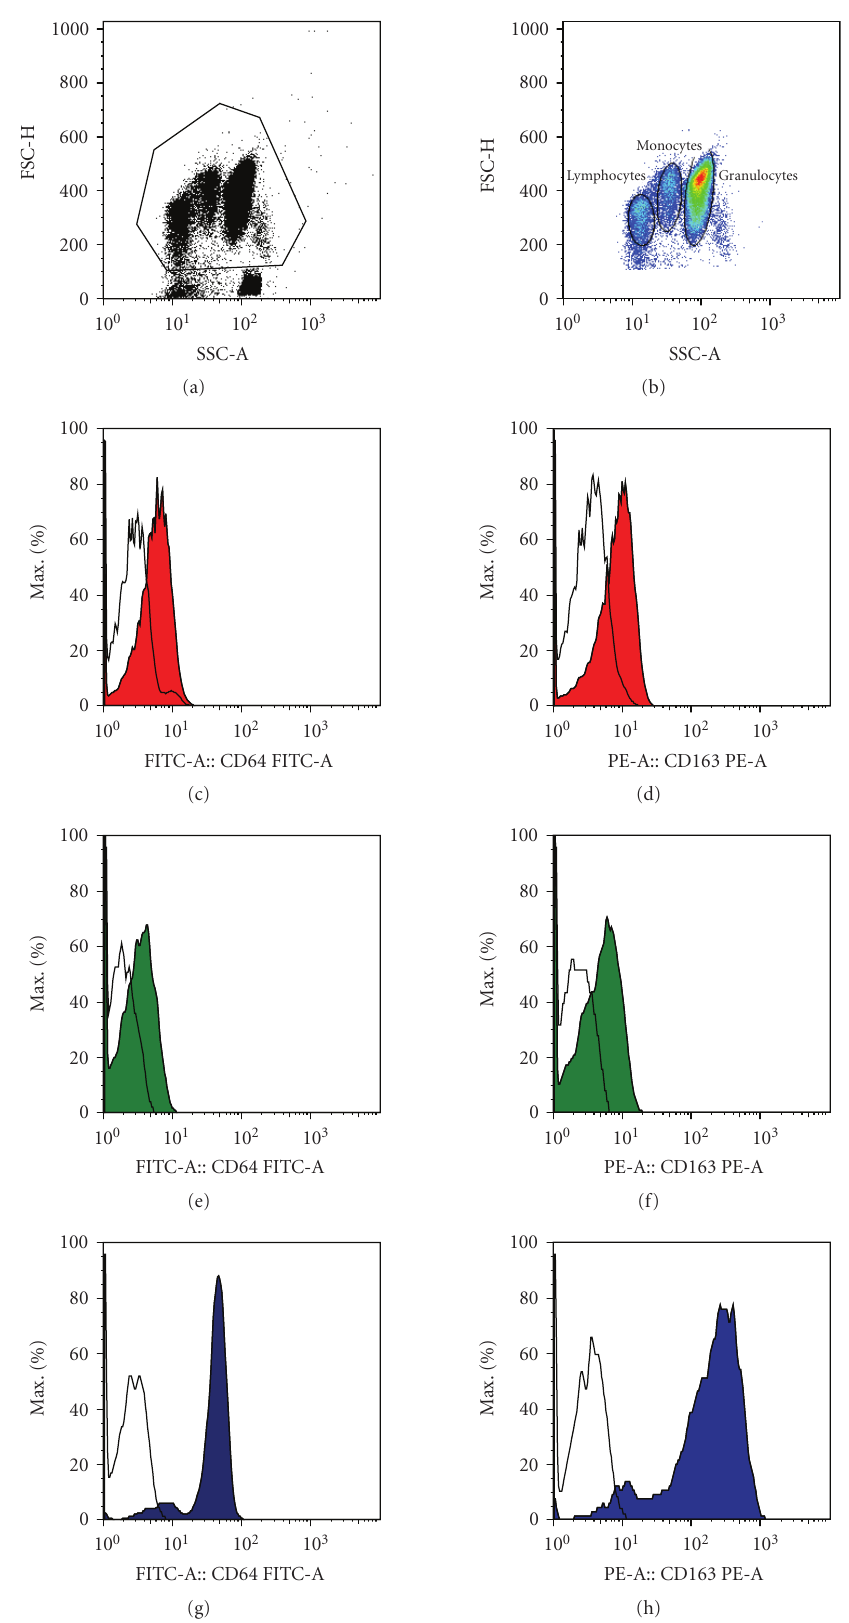
Figure 1: Gating of neutrophils, monocytes, and lymphocytes in FSC/SSC representative FACS diagrams. CD64 and CD163 histograms (colored) versus CD64 isotype controls (lined) are presented for granulocytes (red), lymphocytes (green), and monocytes